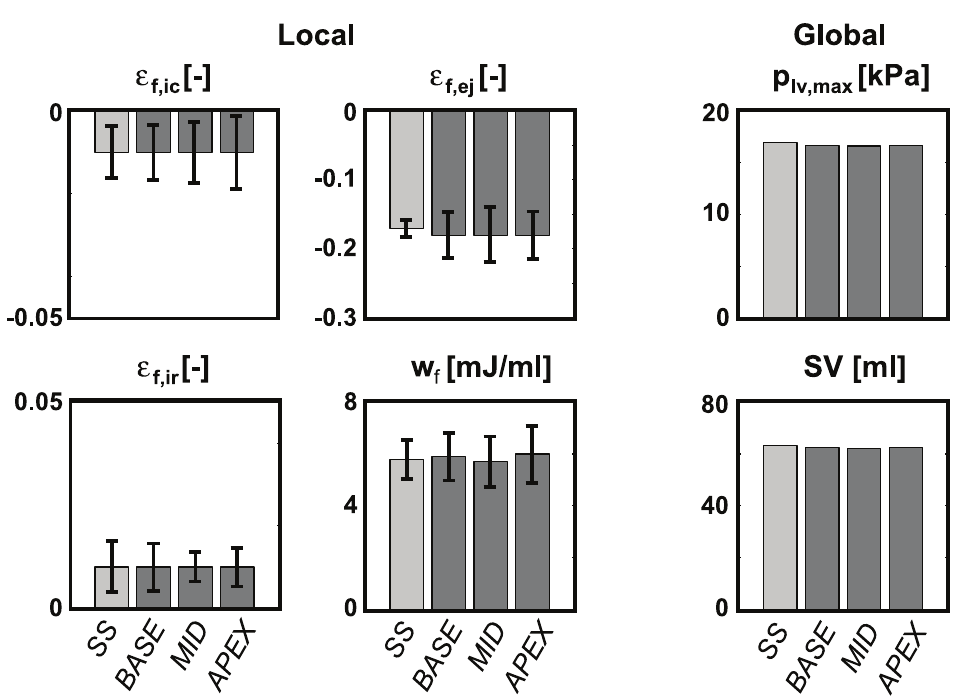
Figure 5. Final LV function after 15 adaptation cycles in the SS simulation and the three SIT simulations ( BASE , MID , APEX ). Mean values and standard deviation (SD) of local function parameters are presented left, values of global parameters right. Differences between simulations are not significant.